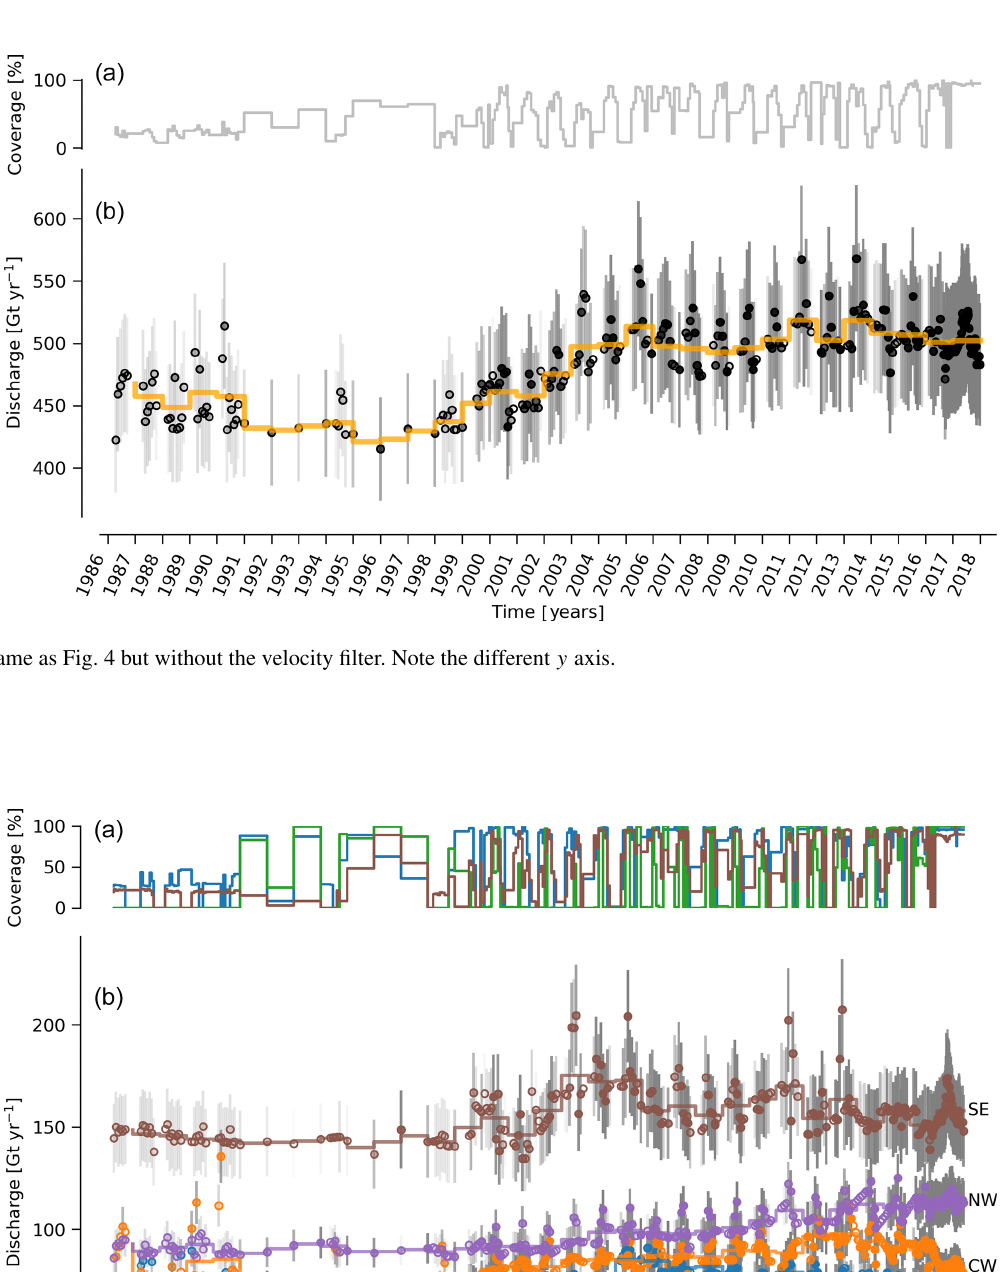
Earth Syst. Sci. Data, 11, 769–786, 2019